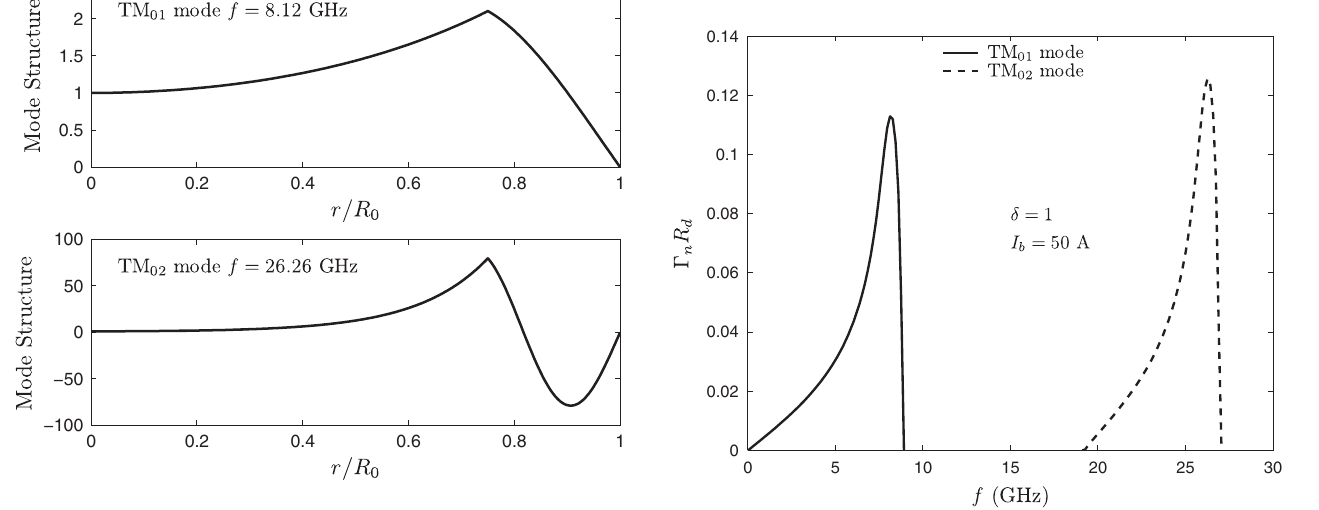
FIG. 3. Mode structure for TM 01 and TM 02 modes at 8.12 and 26.26 GHz. Note that the mode amplitude for the TM 02 mode is unity at r ¼ 0 .